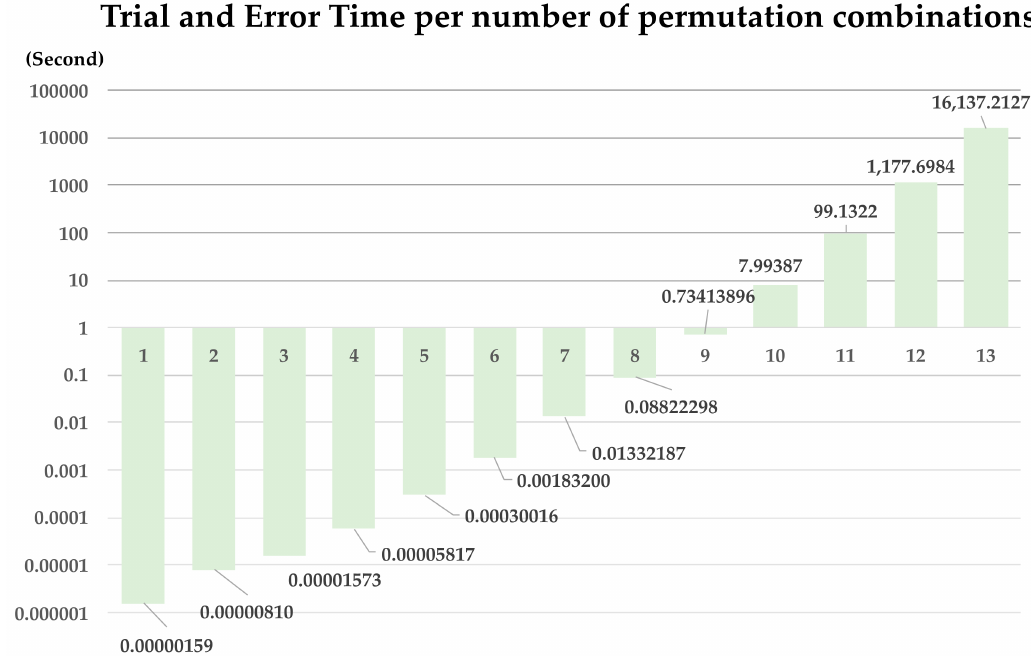
Figure 15. Experiment result of Section